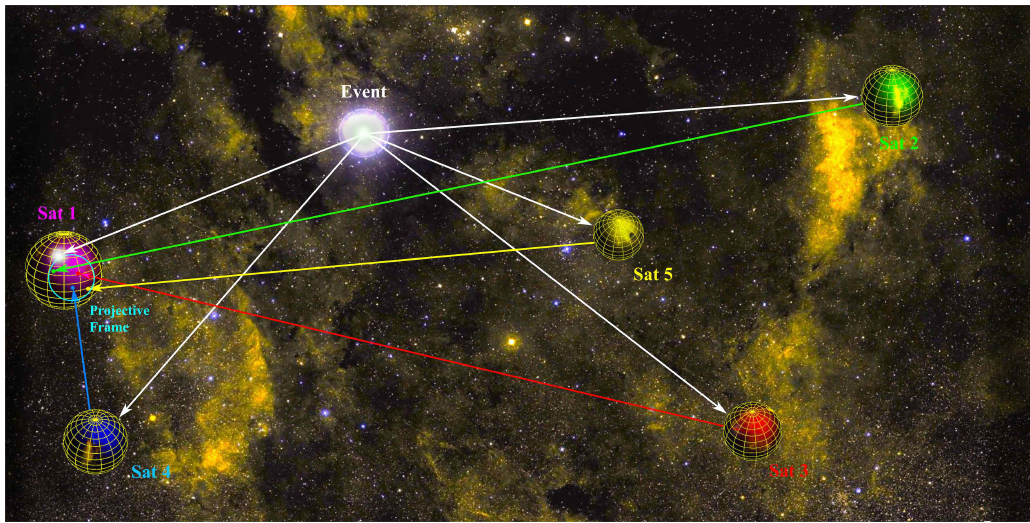
Figure 1. The five satellites (Sat) of a relativistic localizing system (RLS) and an event in an interstellar medium. A projective frame for P R 2 is represented by the four colored points on satellite 1 spherical retina.